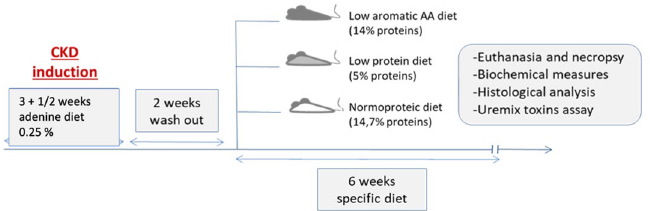
Figure 6. Experimental design of the study. Schematic representation of the experimental study. Half of the C57BL/6J mice were fed with an adenine diet 0.25% for 4 weeks to induce chronic kidney disease (CKD). After 2 weeks of washout, mice were divided into 6 subgroups to receive either a low protein diet, a low aromatic amino-acid diet or a normoproteic diet until terminal sacrifice after 6 weeks of specific